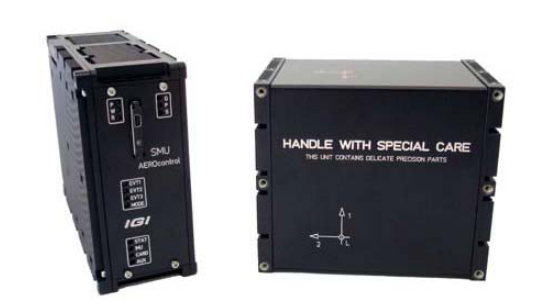
Figure 3. IGI AEROcontrol (source: